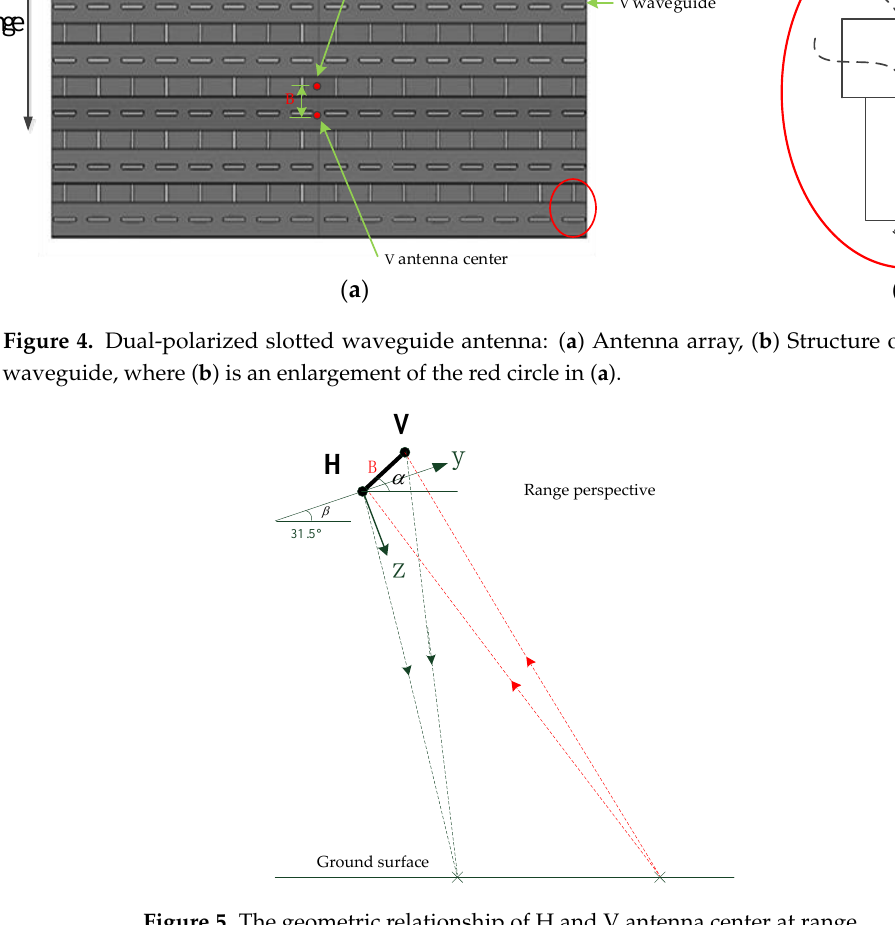
Figure 5. The geometric relationship of H and V antenna center at range.